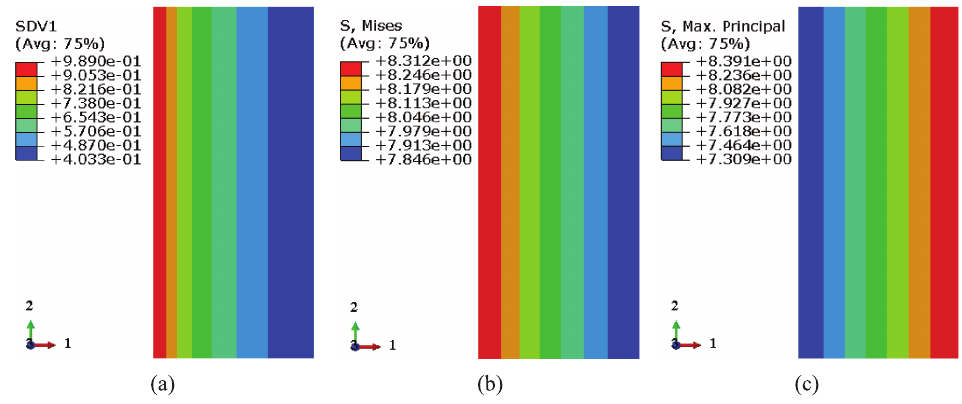
Fig. 5: The distribution of SDV1, σ e and σ p after operating for 75,500 h at 1050 °C: (a) SDV1; (b) σ e ; (c) σ